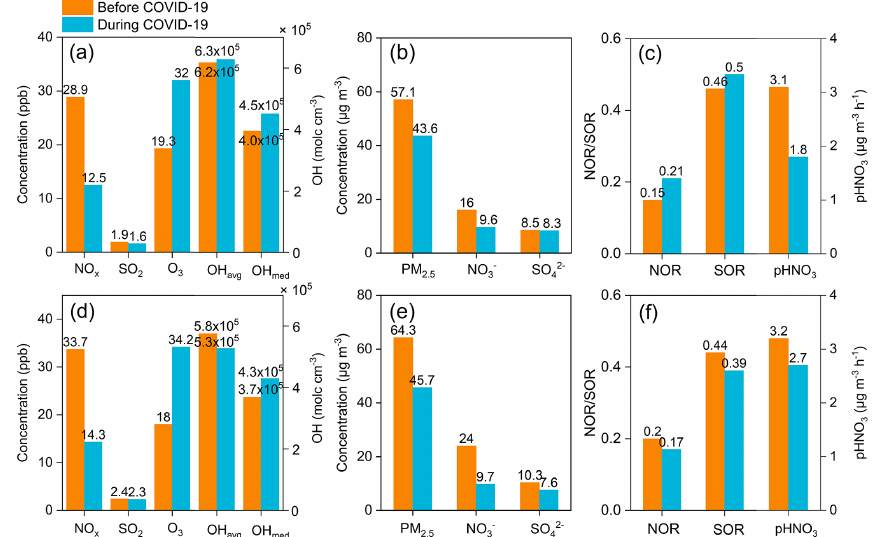
Figure 11. Average concentrations of NO x , SO 2 , O 3 , OH radicals, PM 2 . 5 , nitrate, and sulfate, as well as the nitrogen and sulfur oxidation ratio (NOR and SOR) at (a–c) Pudong and (d–f) Qingpu sites before (1–22 January 2020) and during (23 January–12 February 2020) the COVID-19